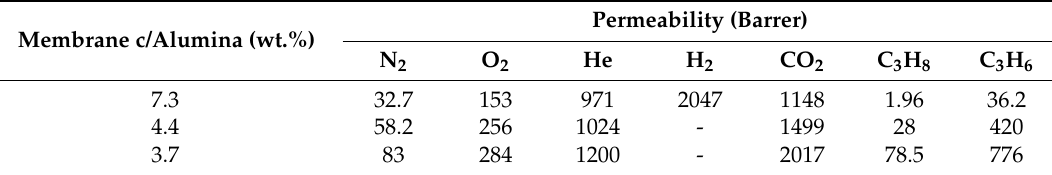
Figure 2. ( a ) SEM image of a supported composite Ag‐alumina‐CMSM, bright spots indicate the presence of Ag; ( b ) Gas permeation results for propene/propane and comparison with the respective upper bound plot. Reproduced with permission from [52], Elsevier, 2012.